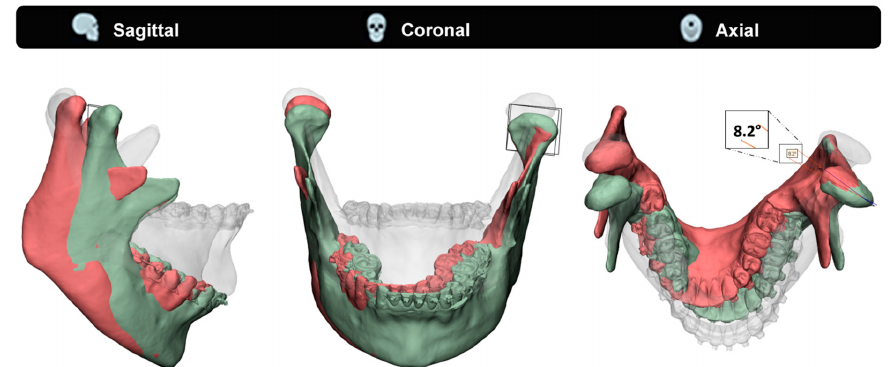
Figure 7. An illustration showing the effect of a wrongly positioned unilateral fixed centre of rotation (CR) simulating a TMJ-TJR prosthesis on the right side, on the healthy contralateral joint. In transparent the occlusal mandibular position is shown. Green indicates the maximum opened mouth according to the recorded physiological data, and red shows the simulated mouth opening according to scenario ‘Unilateral fixed CR R ( − 15 mm)’ in Figure 6. The unilateral fixed CR R ( − 15 mm) scenario is where the left condyle follows the physiological path, whilst the right side has a fixed CR applied too close to the centre of condyle position for this specific patient. Note again the severe lateral deviation of the red mandible and the unnatural rotation this forces on the contrala- teral healthy joint. In this specific case, the left condyle is forced to rotate an 8.2 degree angle in the axial plane upon opening compared to the physiological opened condyle position. In patients with restricted mandibular movement, e.g., due to severe unilateral an- kylosis, performing a 4D-analysis can be challenging, if not impossible, depending on the severity of the restriction of movement. Furthermore, our proposed workflow would be inapplicable for clinicians who do not have access to 4D techniques. Regarding both situ- ations, it could be worth exploring if the PS CR is related to the morphology of the man- dible and fossa and can thus be predicted instead of measured. Among our cohort, we observed that a large portion of the calculated PS CRs lay on or close to the occlusal plane. This observation is supported by prior researchers’ findings [24]. In future work, we would like to test the hypothesis that PS CRs can be predicted based on the morphology of the mandible and fossa. Tools that can be applied to test such typical hypotheses are statistical shape modelling (SSM) [25,26] and principal polynomial shape analysis (PPSA) [27]. By using the segmentations of the mandible and fossa together with the calculated PS CRs from our cohort as input for the model, we can make the model predict the PS CRs of mandibles input without 4D data. Further validation of the SSM/PPSA CRs should indicate if there is any relationship between the mandible’s mor- phology and the position of its CRs. However, in order to establish a robust model, we would need to expand our current cohort. The main limitation of this current study, apart from the relatively small sample size of 20 patients, is the homogeneity of our cohort. Being patients who required CBCT scan- ning for 3D VSP of their BSSO procedure, all patients in this study had a class II or III occlusion (17 vs. 3). Whether these types of malocclusions have an effect on the movement pattern of the mandible, especially mouth opening, remains unclear, as to the best of our knowledge, this cannot be found in the current literature. Scanning a cohort of control subjects might provide us with these answers, but ethics prevent us from CBCT scanning of healthy subjects.